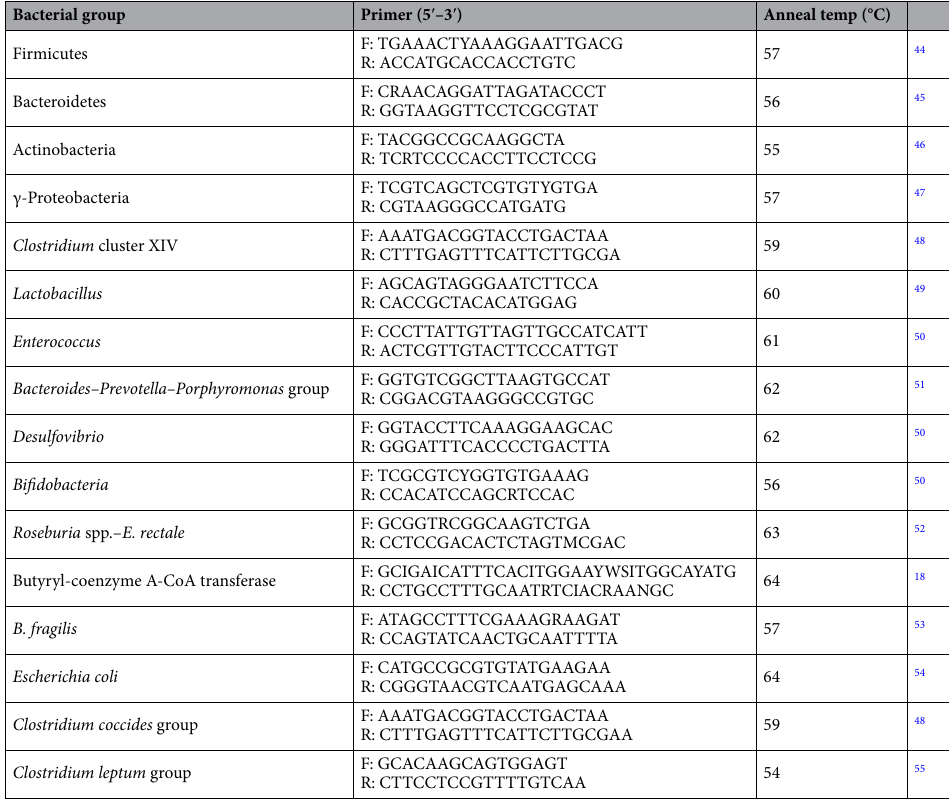
Table 2. Primer sequences for 16S rRNA V1–V3 region of major bacterial